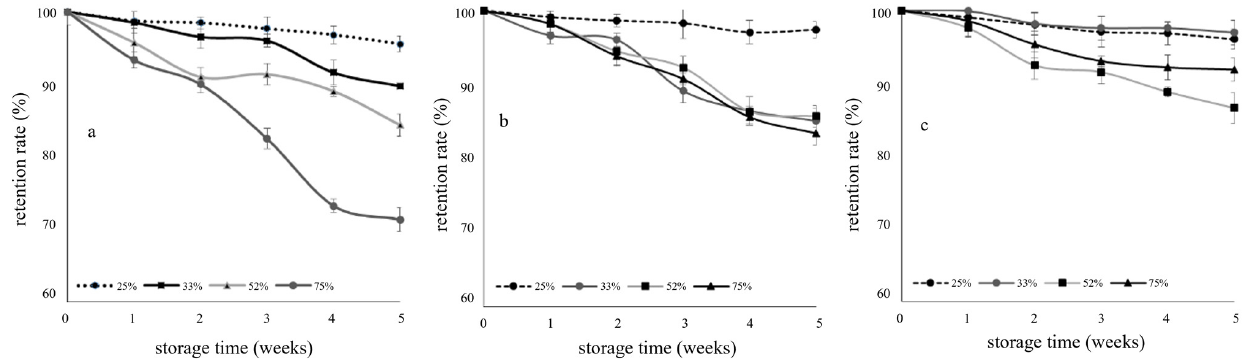
Figure 3. Release time-courses of encapsulated sweet orange oil in spray-dried powders stored at 37 °C and under various a w conditions. ( a ) Large-size powder, LP. ( b ) Small-size powder, SP. ( c ) Nano-size powder, NP.